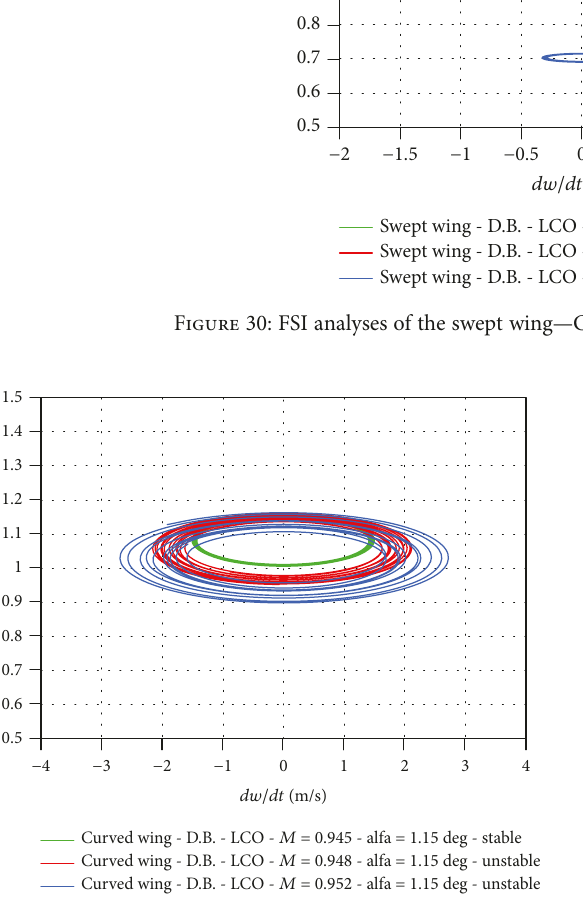
Figure 31: FSI analyses of the curved wing — Case 2 (cruise — tip displacement LCO — DB).